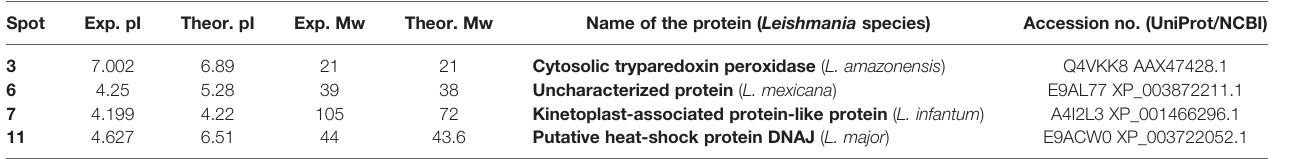
TABLE 1 | Characteristics of the identi fi ed immunodominant proteins. Spot Exp. pI Theor.